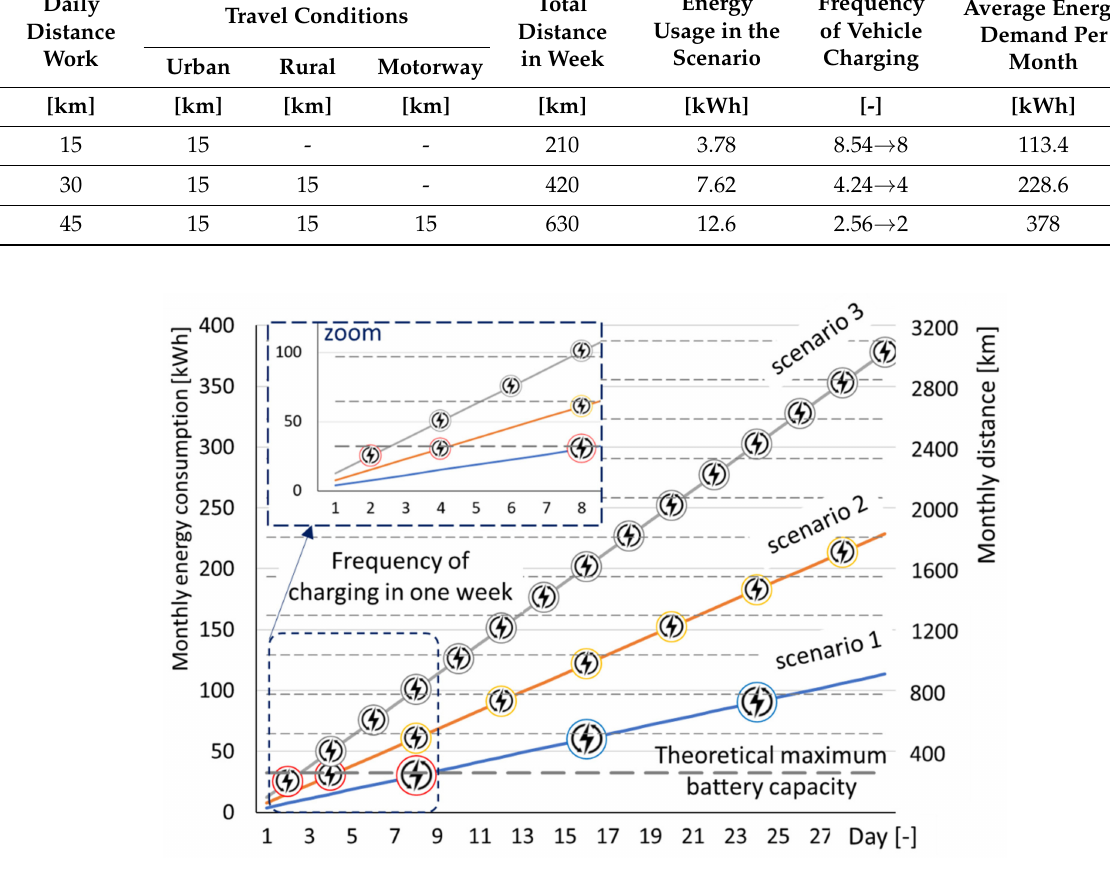
Figure 15. Frequency of charging an electric vehicle in the presented scenarios depending on the distance covered by a